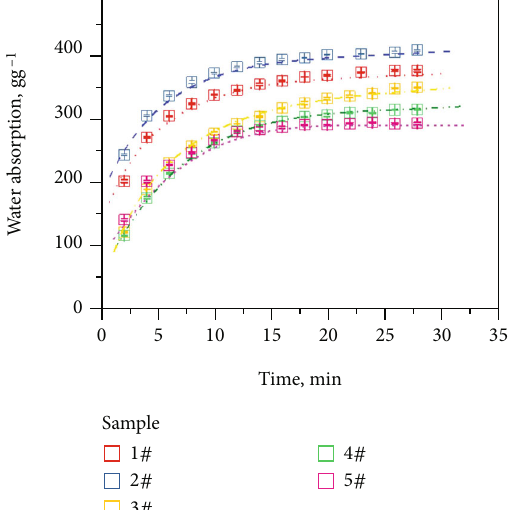
Figure 1: Time-dependent pro fi le of acrylic SAP ’ s